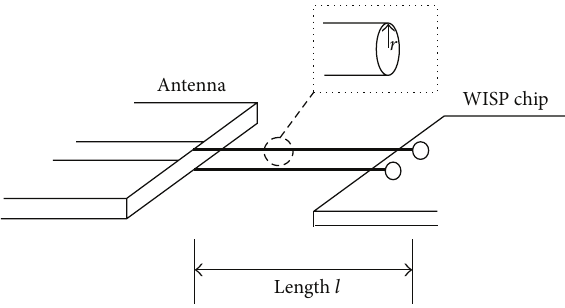
Figure 10: Connection between the antenna and the WISP chip.